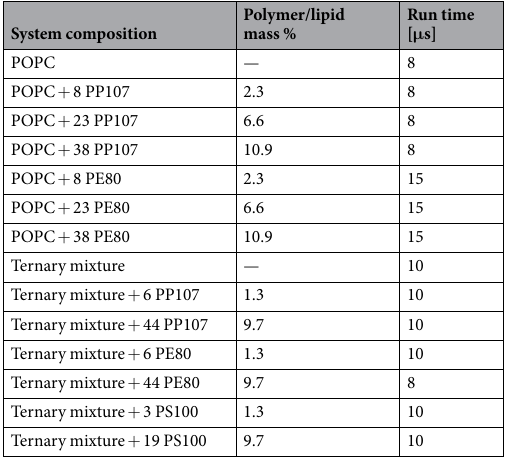
Table 1. List of simulations performed, with lipid composition, polymer composition, and length of the production run. The number following the name of the polymer indicates the number of units in the polymer chain represented at the coarse-grained